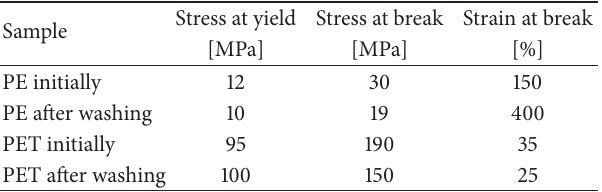
Table 5: Mechanical properties of the PE and PET films before and after enzymatic removal of the interim whey coating from the multilayer